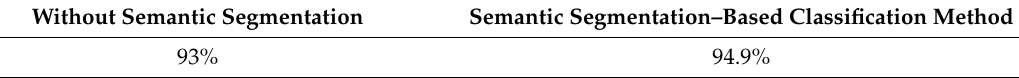
Table 2. Average Accuracy of Shot Type Classification.